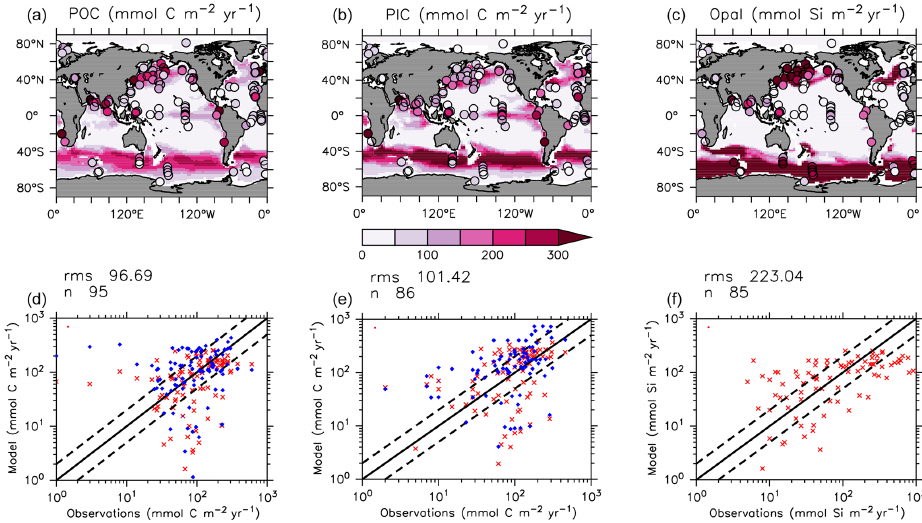
Figure 7. Comparison of model POC (a, d) , CaCO 3 (b, e) and opal (c, f) fluxes at the year 2004 and 2km depth with Honjo et al. (2008) data. Red points are this model (KMBM3); blue points are the Keller et al. (2012) model (KMBM1). Statistics are given for KMBM3 only.